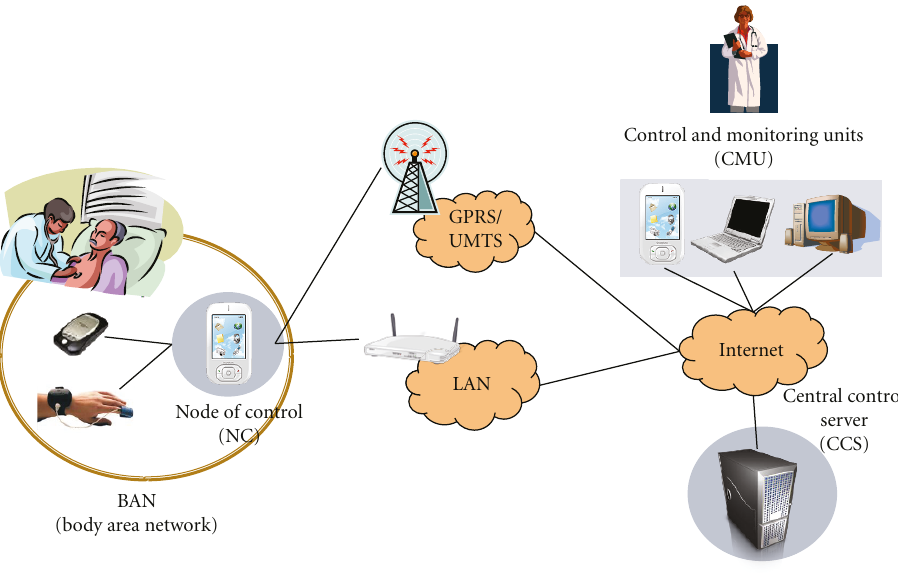
Figure 1: Architecture of monitoring